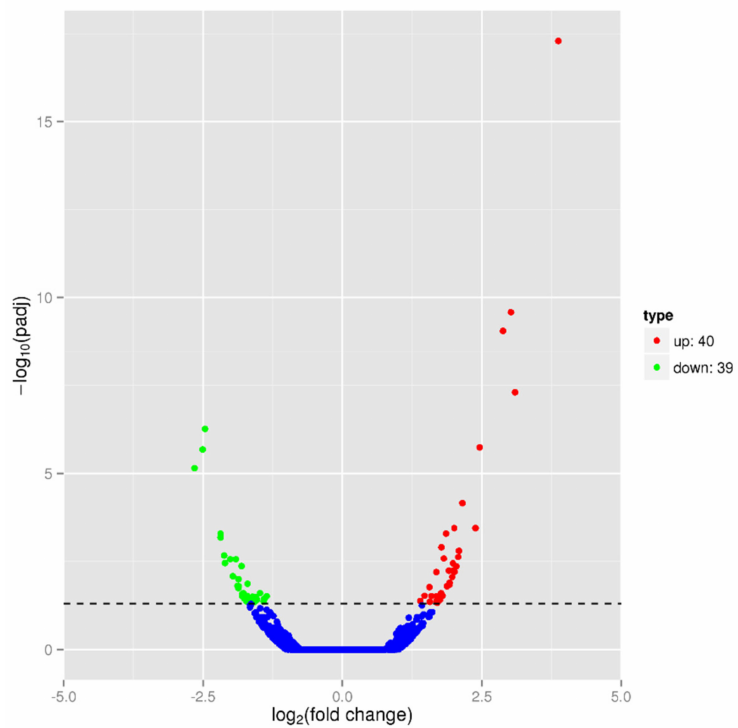
Figure 2. Volcano plot of DEGs in the NBF and